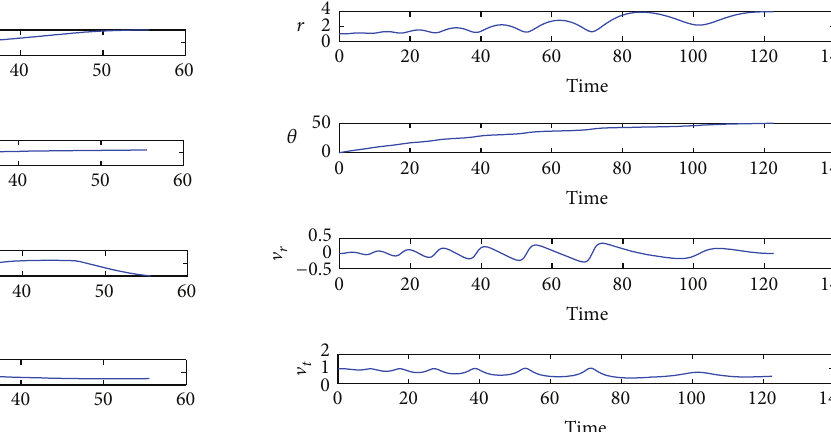
Figure 13: Time history of state variables.